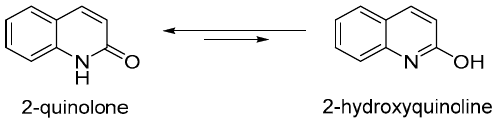
Figure 2. Tautomerization between 2-quinolone and 2-hydroxyquinolone.